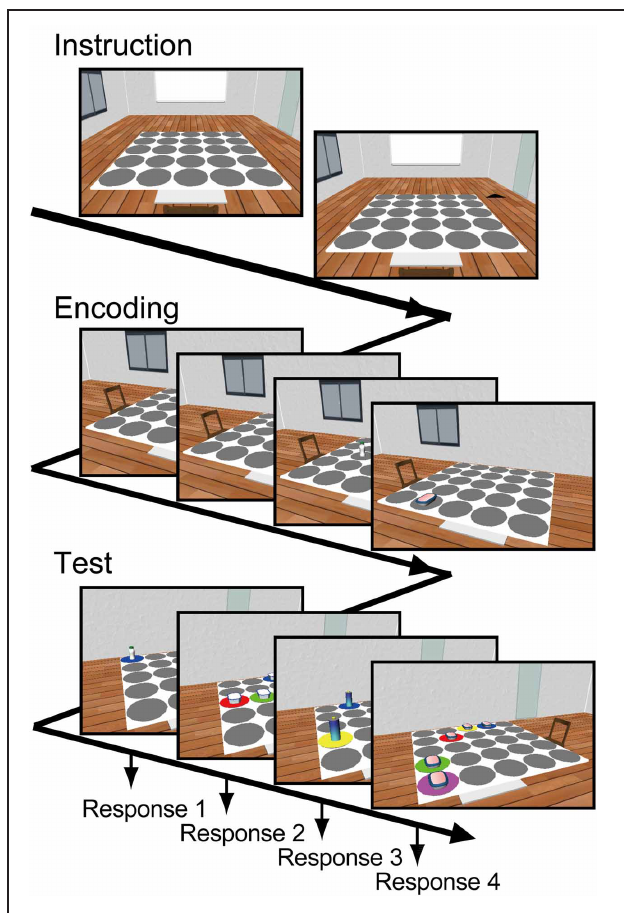
FIGURE 1 | Working memory task. Each trial consists of instruction, encoding, and test phases. At the beginning of the trial, a starting viewing position in the environment was stated to the subject. Then, four snapshots viewed from the instructed position, including different objects located at different placeholders on the table, were presented for 3.1s each. Two of the four snapshots were presented with flicker. The participants were asked to remember each object’s location. During the test phase, the memory of each object’s location was tested from a different viewing position by using a snapshot including the original object at the original location and four foils of identical objects at different locations. The participants were asked to report the correct object’s location by using a